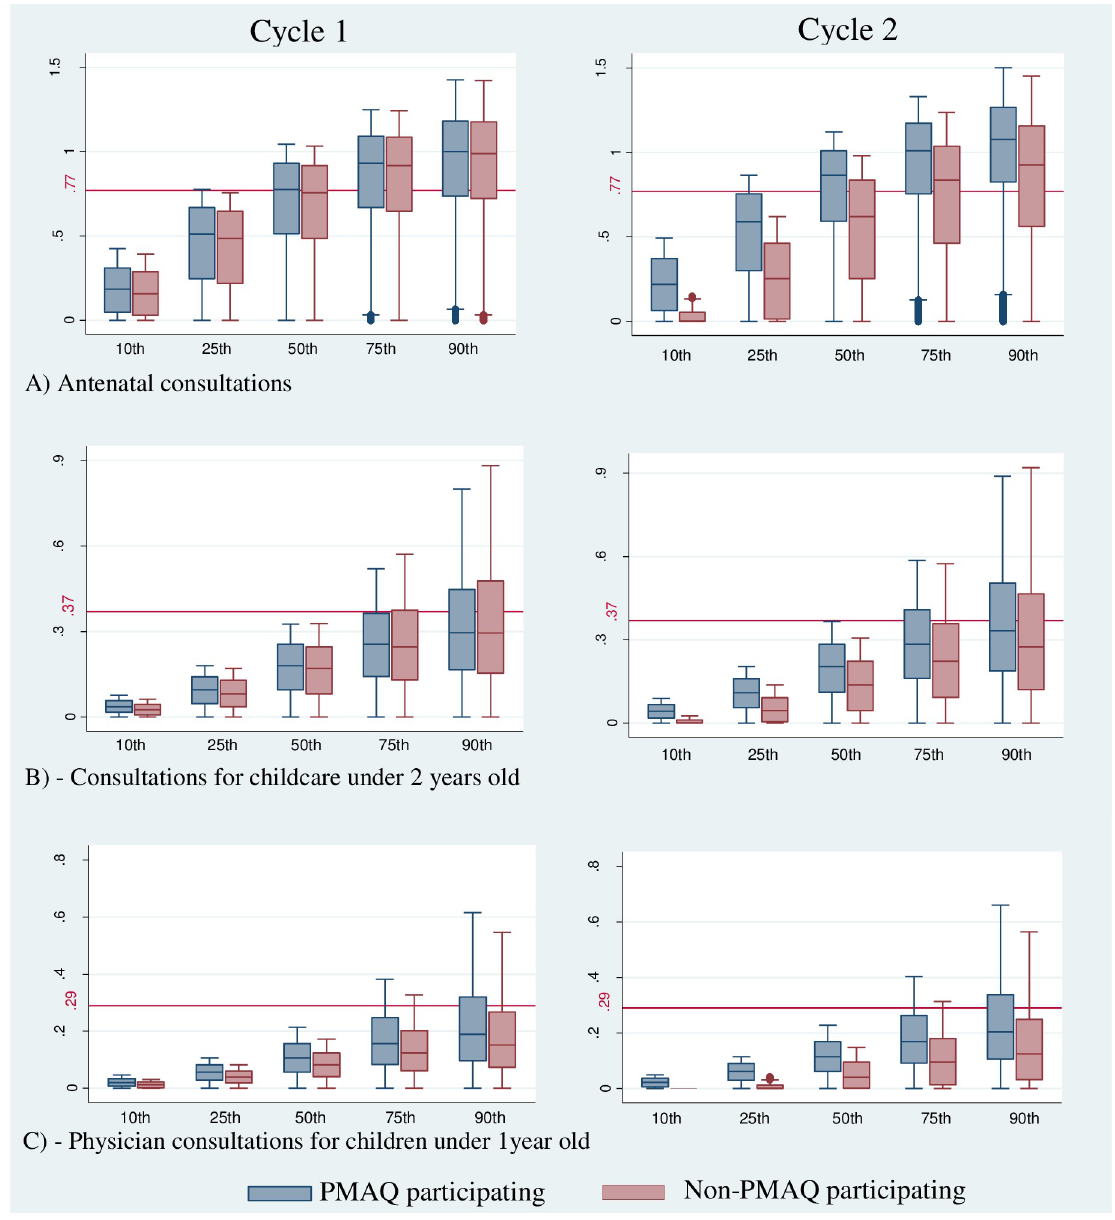
Fig 1. Cumulative distribution of the average consultations per month for maternal and childcare performed by PMAQ participating and non-participating teams in cycles 1 and 2, Brazil, 2011–2014. Number of consultations per month recommended by the Ministry of Health (red line). Central line shows median achievement and box shows interquartile